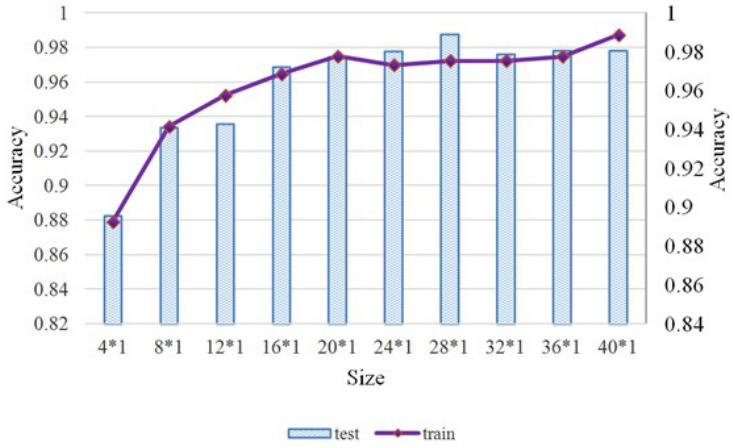
Figure 7. Accuracy statistics for different convolution kernel